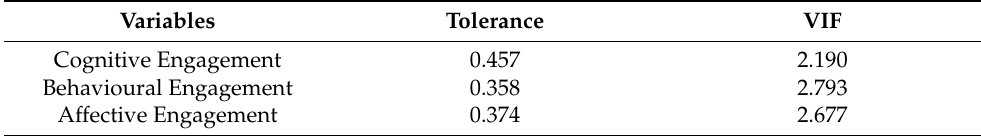
Table 7. VIF and tolerance values for variables.